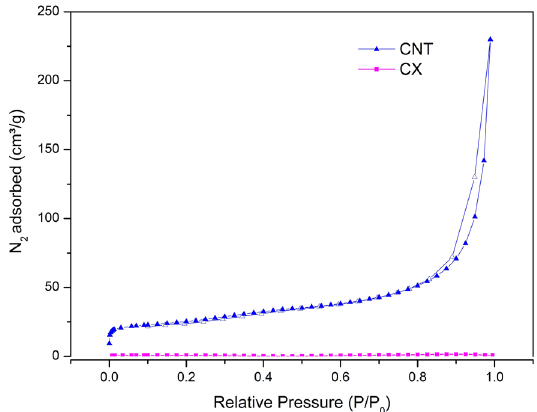
adsorption-desorption (solid and open symbols, Figure 6. N 2 respectively) isotherms of CNT and CX.